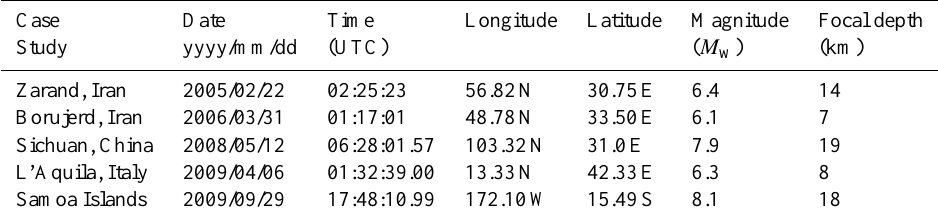
Table 3. List of the earthquakes selected in this study (reported by http://earthquake.usgs.gov/).